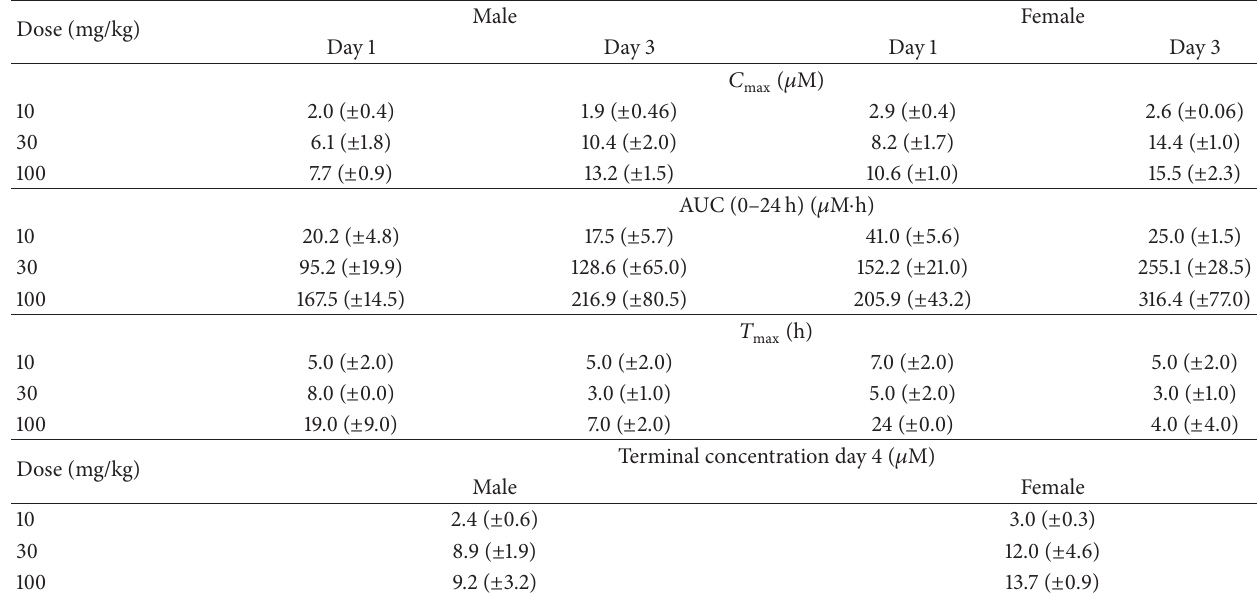
Figure 10: BMS-869780 caused PXR activation in vitro and lipidosis in rat liver. (a) PXR activation in the presence of BMS-869780 was evaluated in HepG2 cell cultures using a luciferase transcriptional reporter construct ( e ), or by assay of CYP3A4 mRNA levels in primary human hepatocyte (PHH) cultures from two individual donors ( 󳵳 and 󳶃 ). Activation in both assays is expressed as % relative to activation in the presence of rifampicin, 10 𝜇 M, in parallel cultures. (b) Liver section from vehicle-dosed rats. (c) Liver section from rats given 4 daily doses of BMS-869780 at 100 mg/kg. A summary of the plasma BMS-869780 exposures from this experiment is shown in Table 5. Table 5: Summary of exposure in rat 4-day dosing